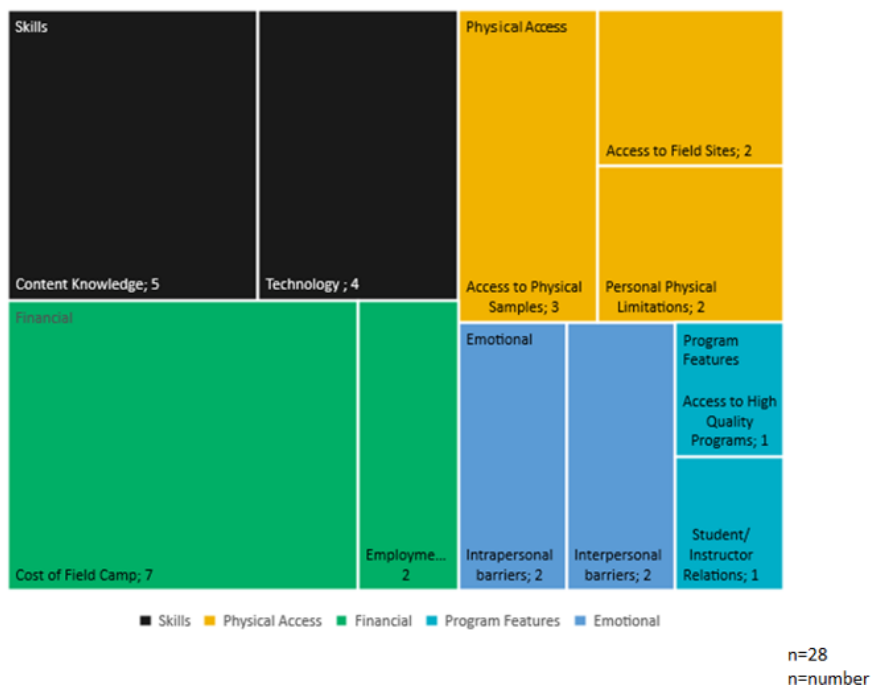
Figure 6. Prior to virtual field camp, students expressed their self-assessed barriers to success in the